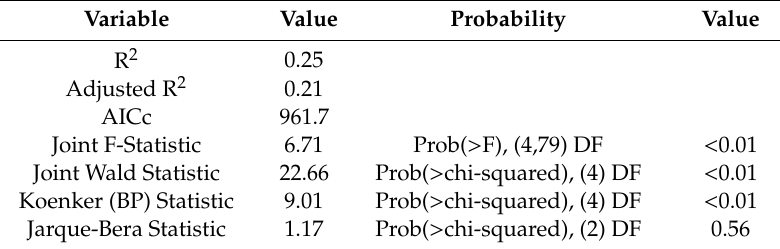
Table 3. The diagnostics from ordinary least square (OLS) regression.